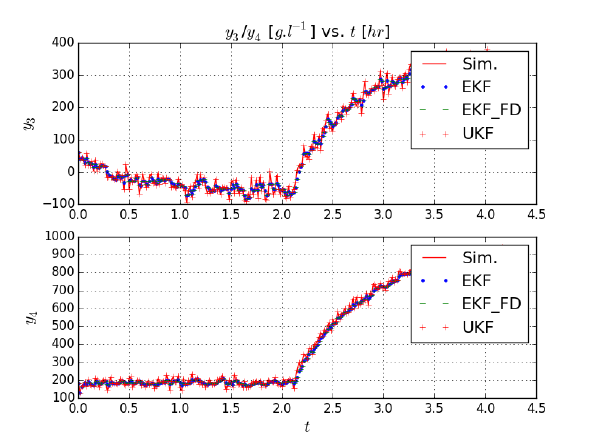
Figure 13: Estimation of z 2 and z